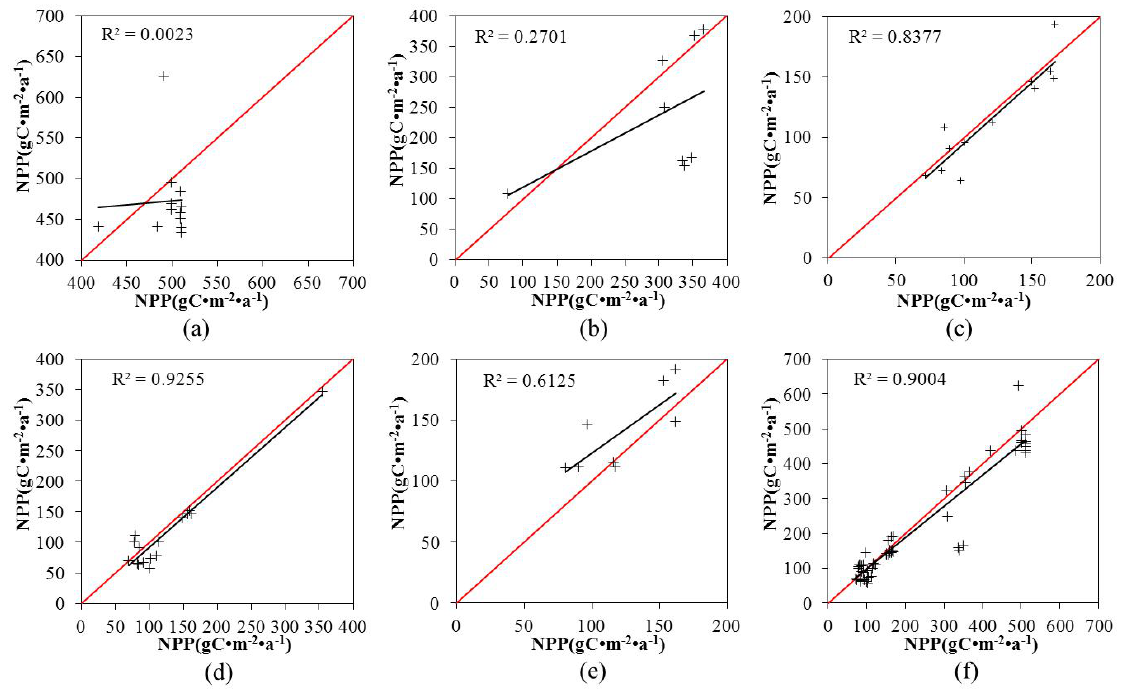
Figure 7. Comparison between model-simulated NPPs without time-series NDVI unmixing (x axis) and ones with time-series NDVI unmixing (y axis) for different vegetation cover, ( a ) for High-coverage xerophilous grassland, ( b ) for Middle-coverage xerophilous grassland, ( c ) for Low-coverage xerophilous grassland, ( d ) for Hygrophilous grassland, ( e ) for Helobious grassland, and ( f ) for all vegetation